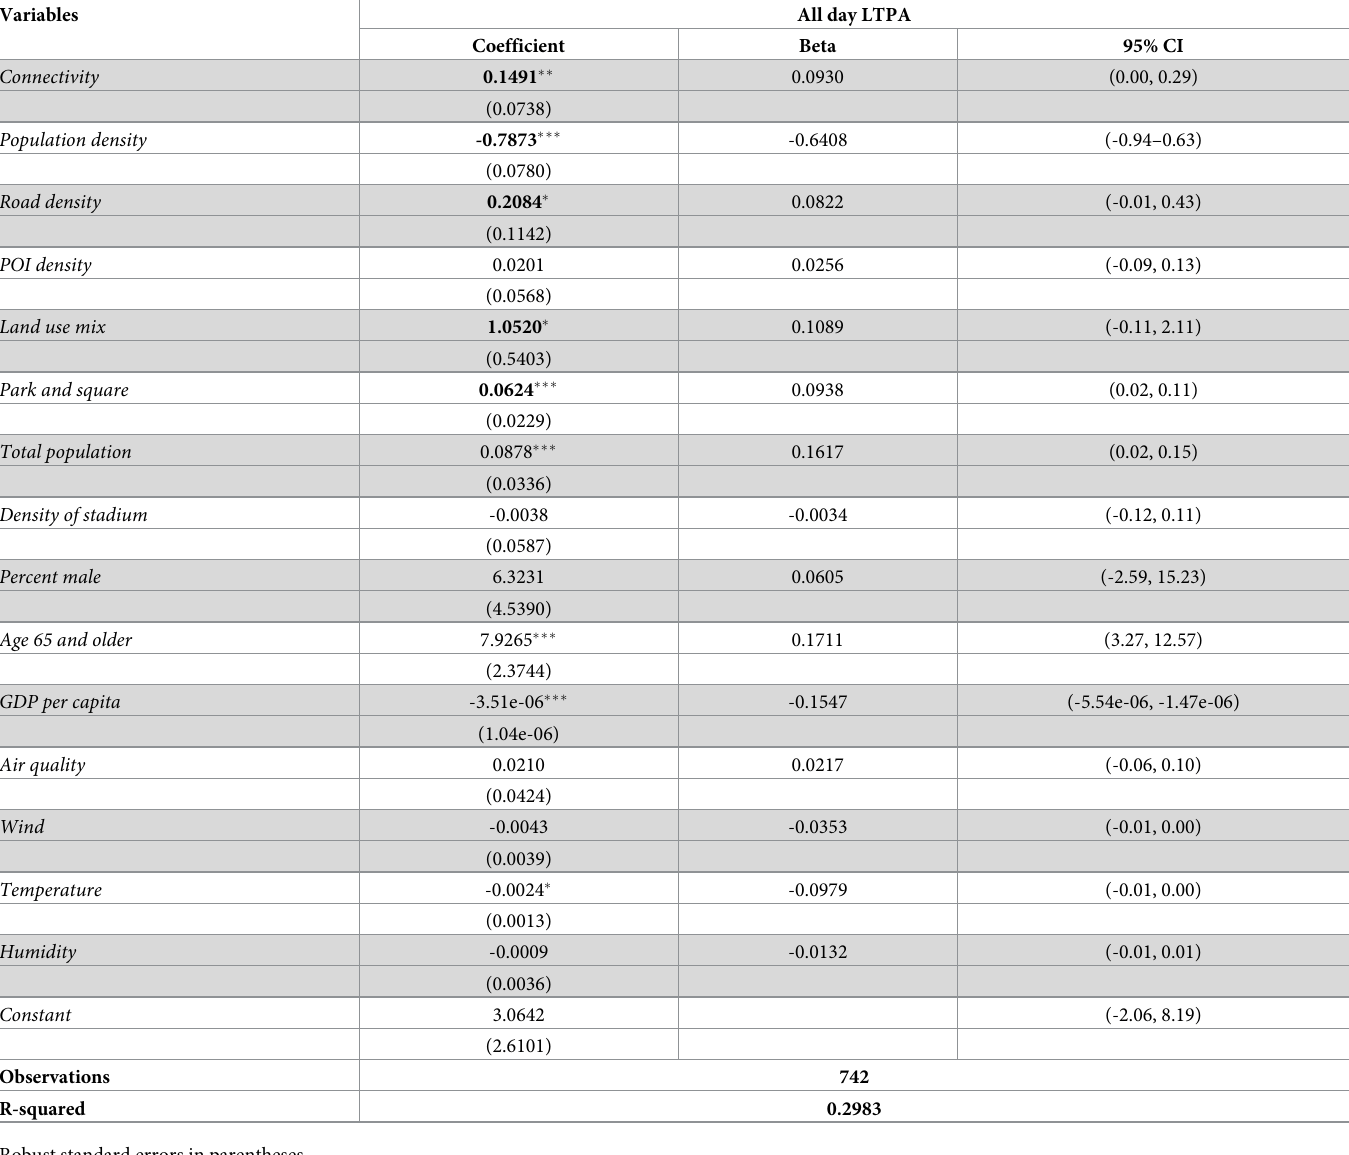
Table 4. Regression results of all day LTPA and built